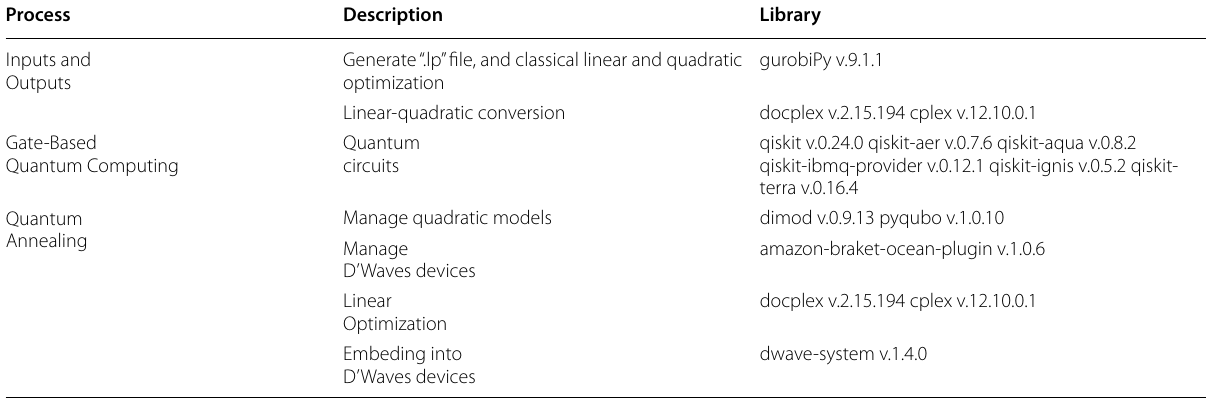
Table 4 Python libraries and associated